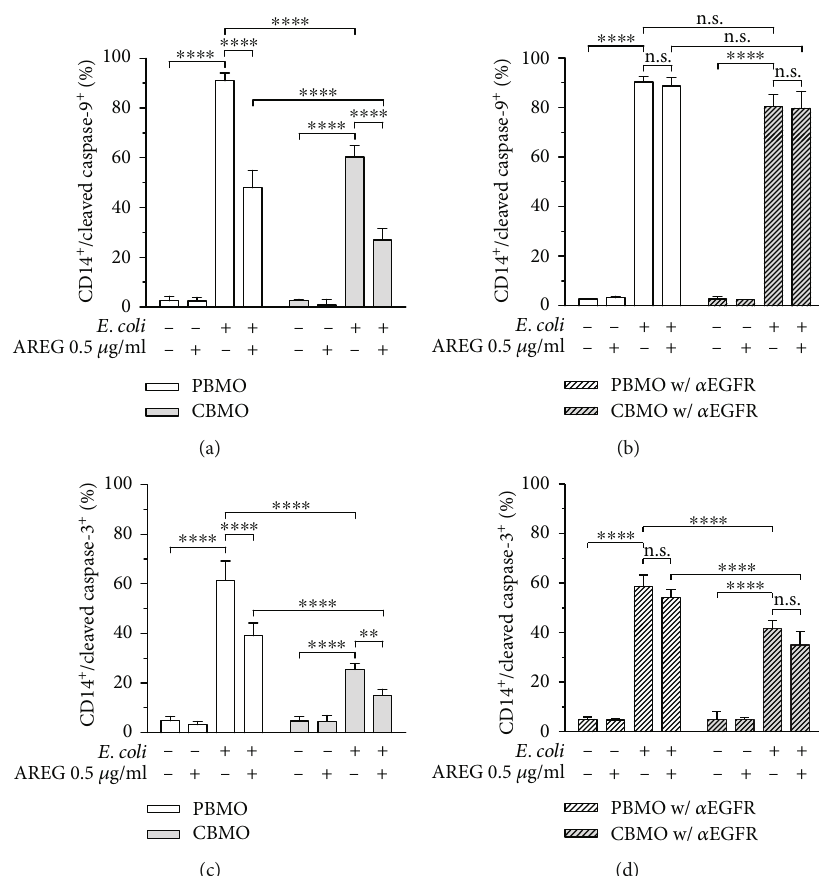
Figure 4: Intracellular levels of cleaved caspase-9 and cleaved caspase-3 in PBMO and CMBO in response to infection, AREG stimulation, and inhibition of EGFR. Isolated monocytes were infected with E. coli , extracellular bacteria were removed, and the cells were cultivated for 24h in medium supplemented with antibiotics. 1 h prior to infection, AREG stimulation and EGFR inhibitor treatment were started and maintained during the entire cultivation period. Detection was performed by fl ow cytometry. (a) Cleaved caspase-9 in PBMO and CBMO in response to infection and AREG stimulation. In both PBMO and CBMO, cleaved caspase-9 levels were signi fi cantly increased in response to E. coli infection, whereas AREG stimulation in turn leads to a decrease in cleaved caspase-9 levels ( n = 5 ). (b) E ff ect of EGFR inhibition on cleaved caspase-9 levels in PBMO and CBMO in response to infection and AREG stimulation. EGFR inhibition abolishes the AREG-mediated decrease in cleaved caspase-9 in both infected PBMO and CBMO ( n = 4 ). (c) Cleaved caspase-3 in PBMO and CBMO in response to infection and AREG stimulation. In both groups, cleaved caspase-9 levels were signi fi cantly increased in response to E. coli infection, while AREG stimulation diminishes the e ff ect ( n = 5 ). (d) E ff ect of EGFR inhibition on cleaved caspase-3 in PBMO and CBMO in response to infection and AREG stimulation. In both infected PBMO and CBMO, EGFR inhibition o ff sets the AREG-mediated decrease in cleaved caspase-3 levels ( n = 4 ). Data are shown as means + SD . Statistical signi fi cance was analyzed using two-way ANOVA with Bonferroni ’ s multiple comparisons test. n.s.: not signi fi cant. ∗∗ p < 0 : 01 ; ∗∗∗∗ p < 0 : 001